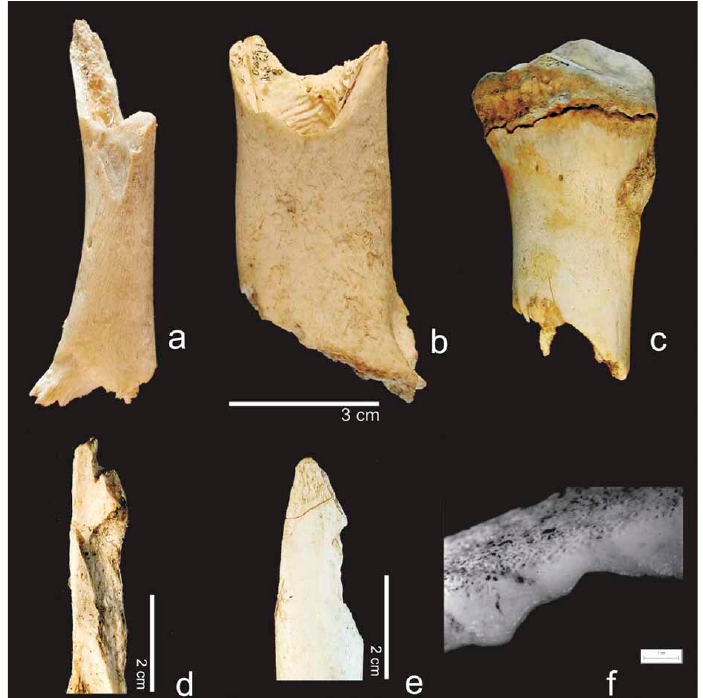
Figure 5. Damage to bones caused by brown bears: ( a – c ) removal of one or both epiphyses, ( d , e ) chipped back edges, ( f ) licking on a breakage plane. Reproduced with permission from Saladié et al. [110]; published by John Wiley & Sons Ltd, 2013.